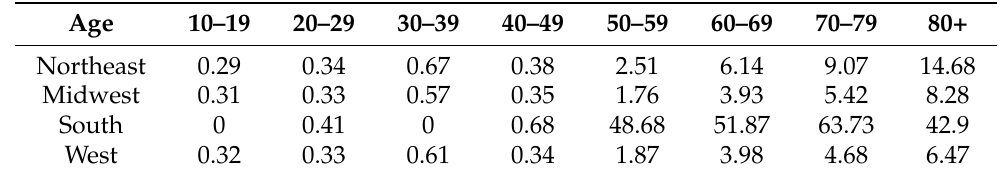
Table 11. Neural network-estimated probabilities of death for an asian male with no pre-existing conditions by region and age group. Given as percentages.